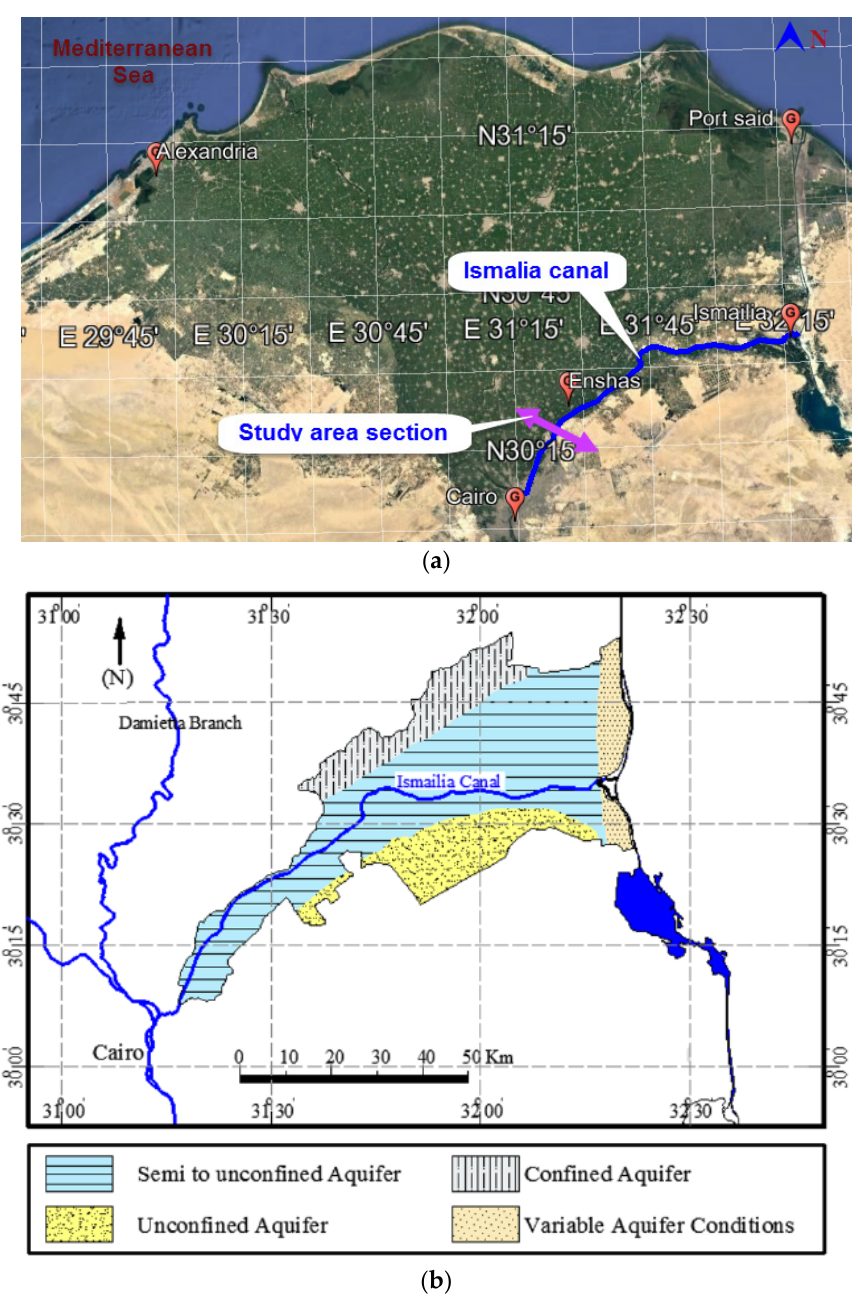
Figure 2. Location map and hydrogeology of the study area. ( a ) Study area location. ( b ) Study area aquifers (Eltarabily, 2020 [5] and modified from Sallouma 1983) [27].